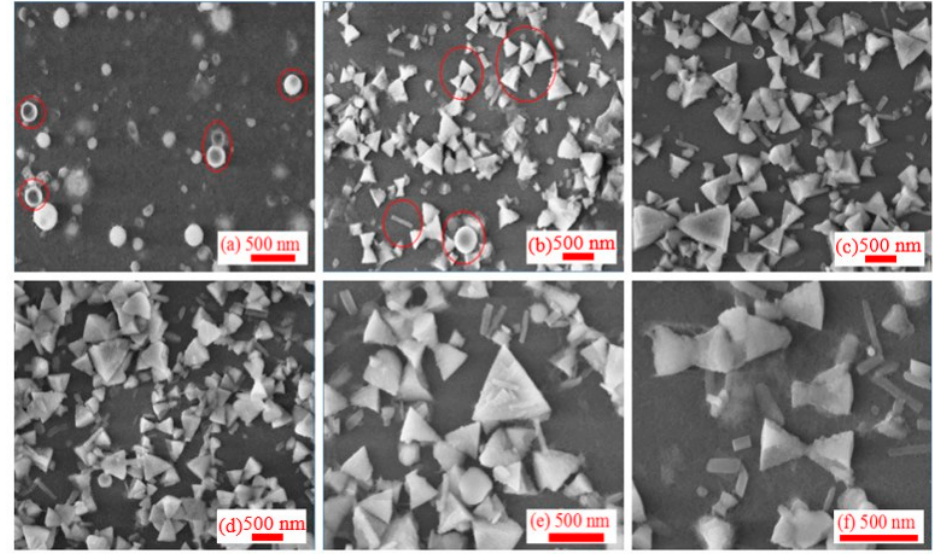
Figure 4. SEM images of NPs at different stages after ablation by 200 ps, 800 nm, 0.54 mJ pulses, ( a ) 1 day, ( b ) 10 days, ( c ) 30 days, ( d ) 60 days, ( e ) 90 days, and ( f ) 100 days after ablation.